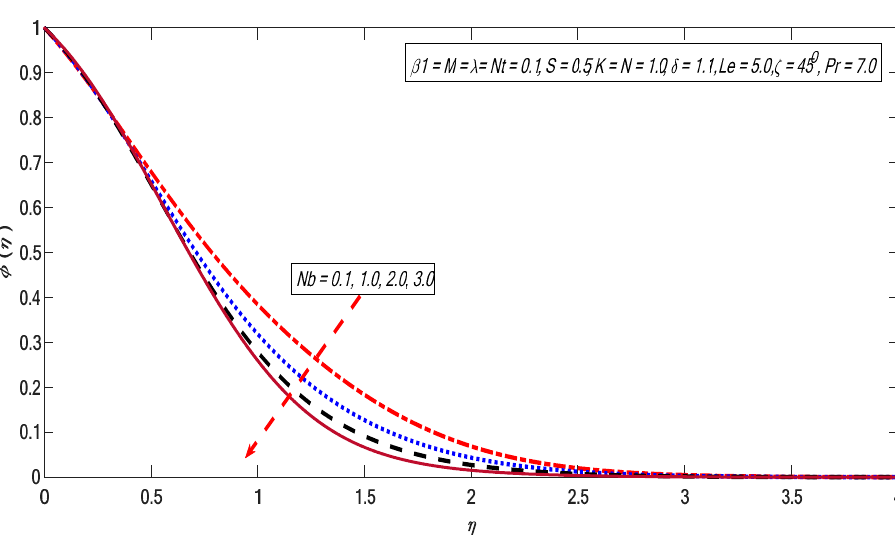
Figure 17. Variations in concentration profile for several values of 𝑁𝑡 . Figure 18. Variations in concentration profile for several values of 𝑁 .